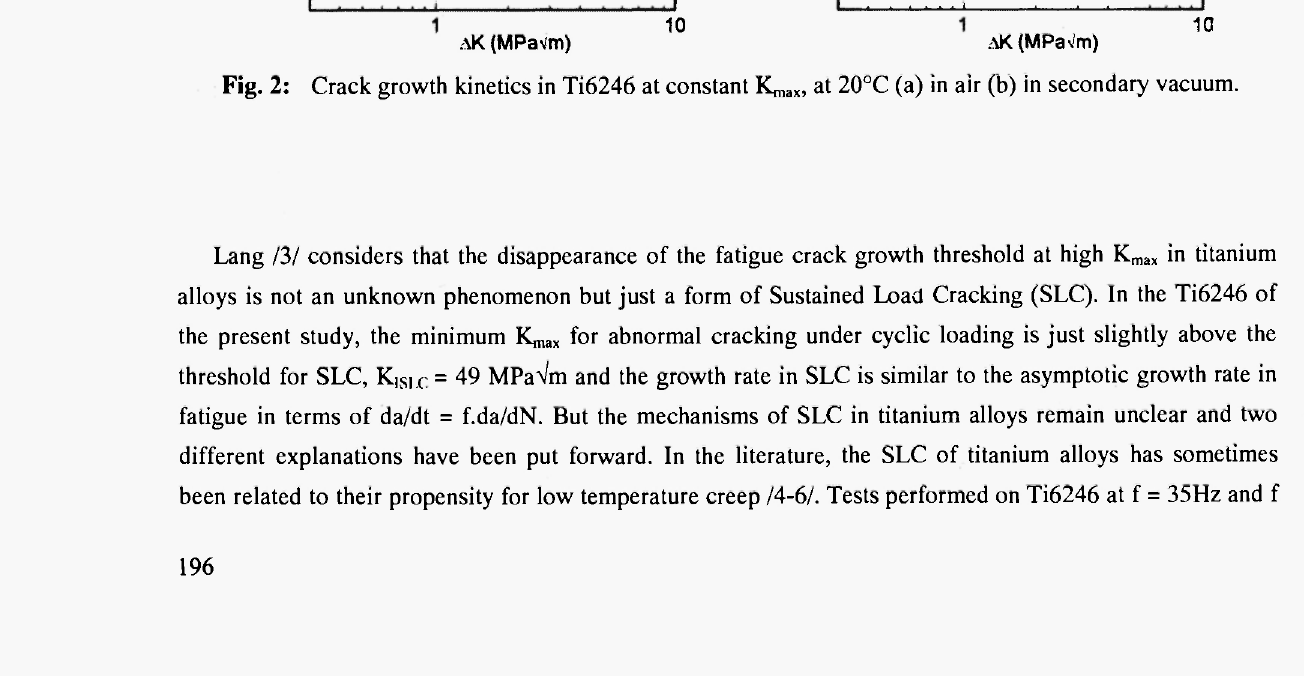
Fig. 2: Crack growth kinetics in Ti6246 at constant Κ™ χ , at 20°C (a) in air (b) in secondary